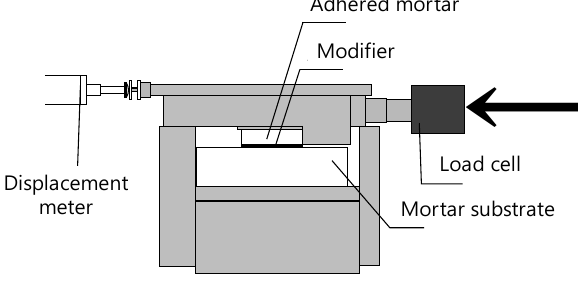
Figure 12. Shear bond strength